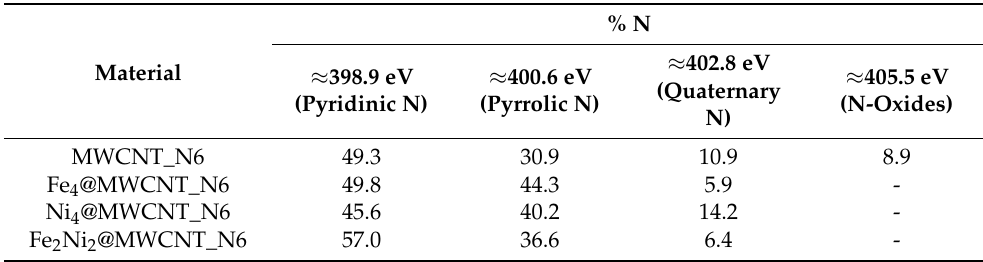
Table 2. Relative atomic percentages of nitrogen obtained from the XPS high-resolution N1s spectra of the prepared carbon